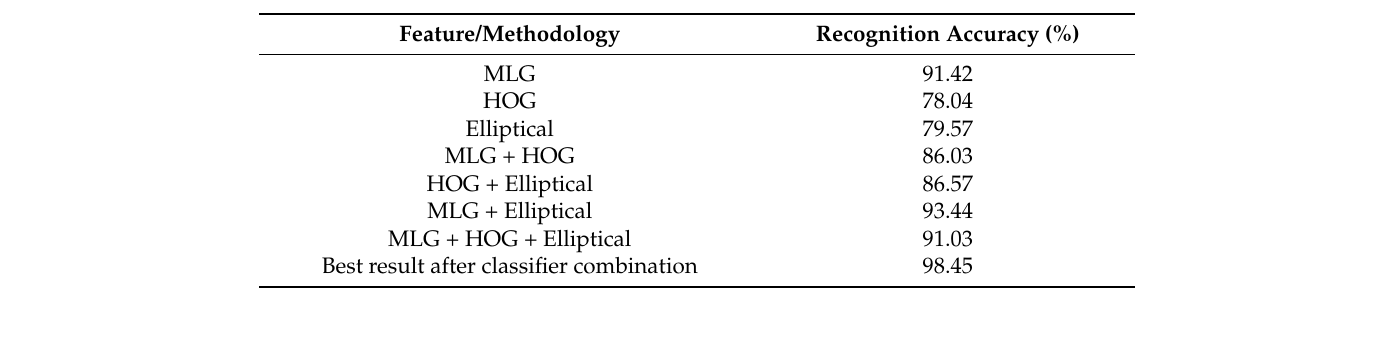
Table 19. Final combination results at feature